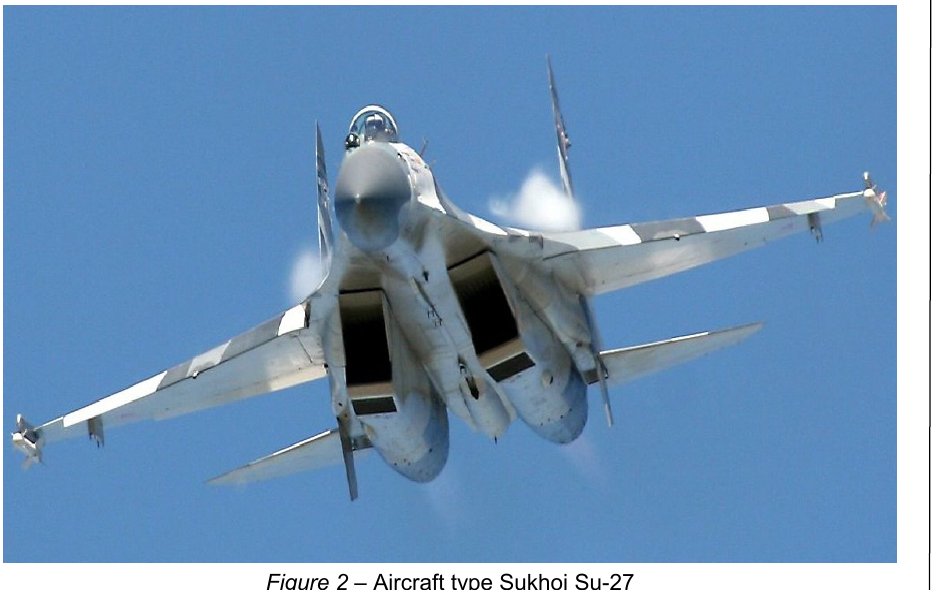
Figure 2 – Aircraft type Sukhoi Su-27 Рисунок 2 – Самолет Сухой , марка Су